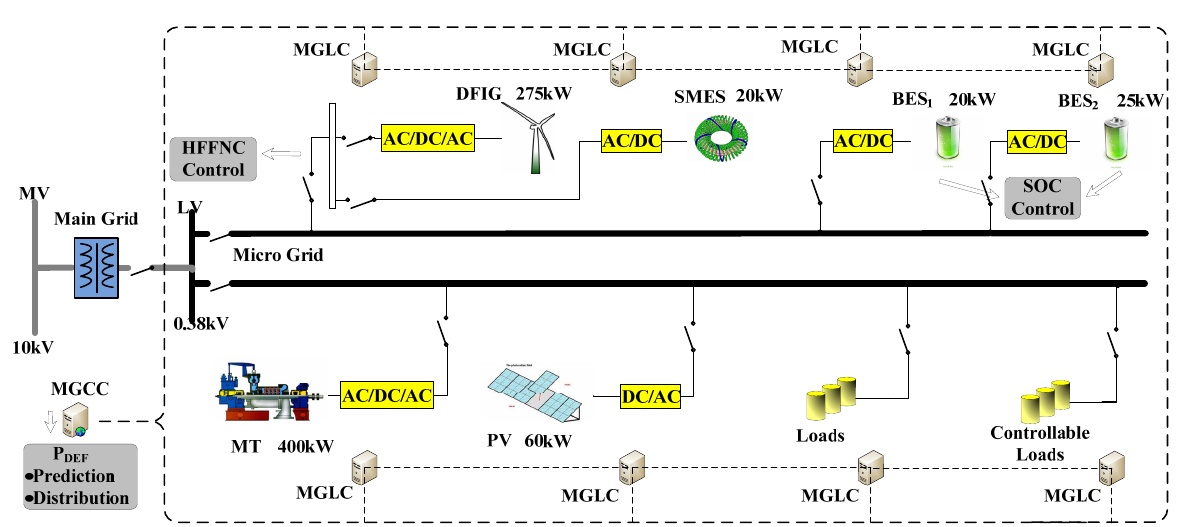
Figure 7. Simulation